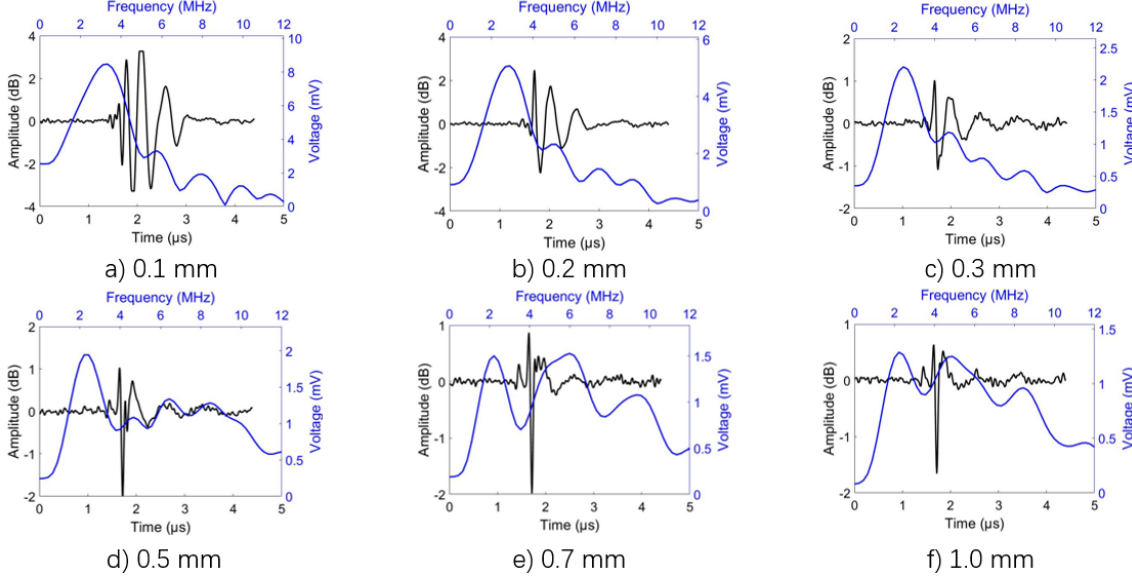
Figure 6. ( a ) 0.1 mm, ( b ) 0.2 mm, ( c ) 0.3 mm, ( d ) 0.5 mm, ( e ) 0.7 mm, and ( f ) 1.0 mm A − scan signal of six different depth defects and the spectrum signals obtained after Fourier transform.